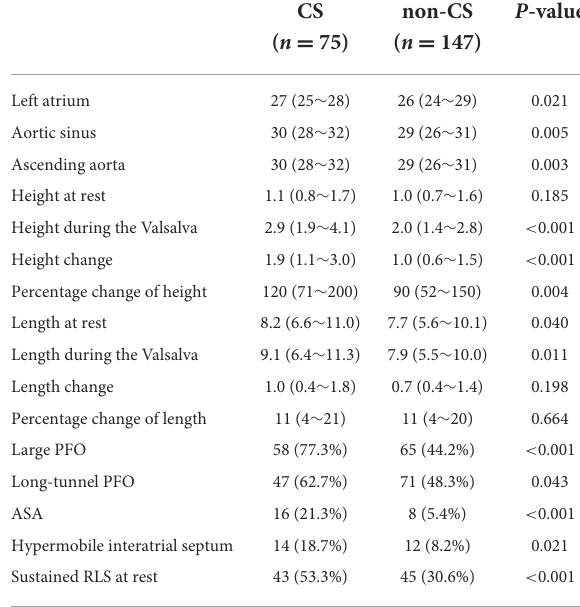
(Figure 1A). The proportion of CS patients increased with this point, as shown in Figure 1B. Based on the average probabilities of 0–25%, 25–50%, and 50–100% (14), we divided the system into low-, medium-, and high-risk grades, which matched the score point ranges: 0–2, 3–5, and 7–12, respectively (Figure